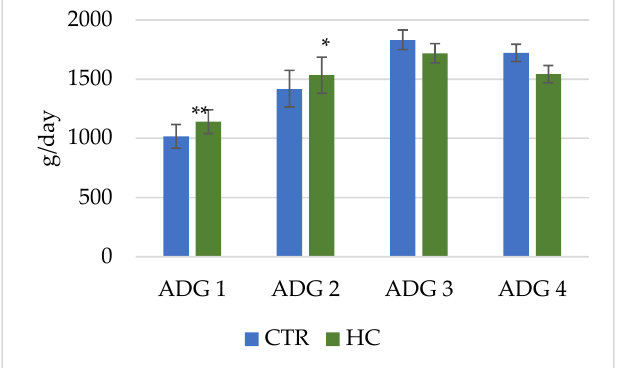
Figure 1. Least square means of average daily gain for control (CTR; blue bars) and hemp cake (HC; green bars) groups of veal calves during the different phases of the experiment (ADG1; 1 – 38 days, ADG2; 39 – 80 days, ADG3; 81 – 122 days, ADG4; 123 – 171 days). Differences between treatments within phase have been reported when significant: (*) p < 0.05, (**) p < 0.01.